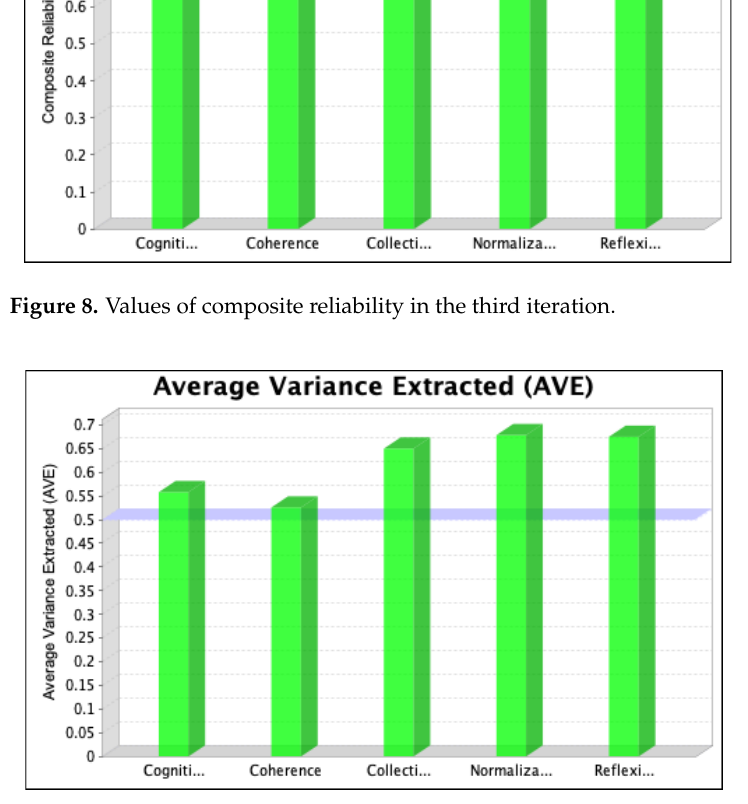
Figure 9. Values of average variance extracted in the third iteration.